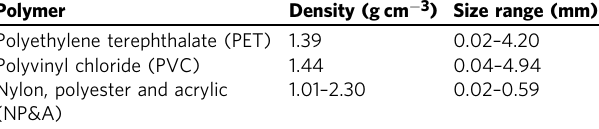
Table 1 Summary of microplastic properties used to settling